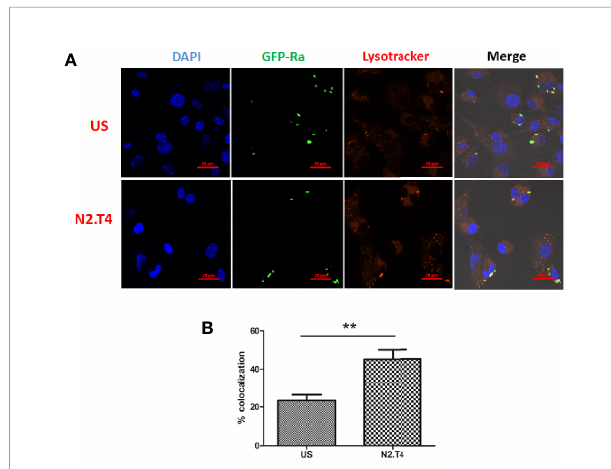
FIGURE 4 | Triggering MSCs through N2.T4 induced traf fi cking of Mtb to autolysosomes. (A) MSCs (2 X 10 5 cells/well)were infected with GFP- Mtb (H37Ra) for 4h followed by signaling through N2.T4 for 12h. Later, the lysosomes were stained with LysoTracker Red for 20 min. The cells were fi xed with PFA (4%) and slides were prepared for confocal microscopy. The panel shows the representative image of Mtb (green channel, 488 nm) colocalization with LysoTracker Red (red channel, 561 nm) (60X). (B) The data from (A) are also illustrated as a graph depicting the percentage of colocalization of Mtb with the lysosome. The data shown as mean ± SEM are representative of three independent experiments. Statistical signi fi cance was determined using the unpaired t-test. **p <